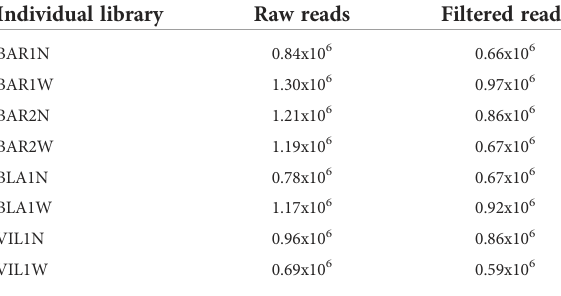
TABLE 1 Number of raw and fi ltered reads per individual and